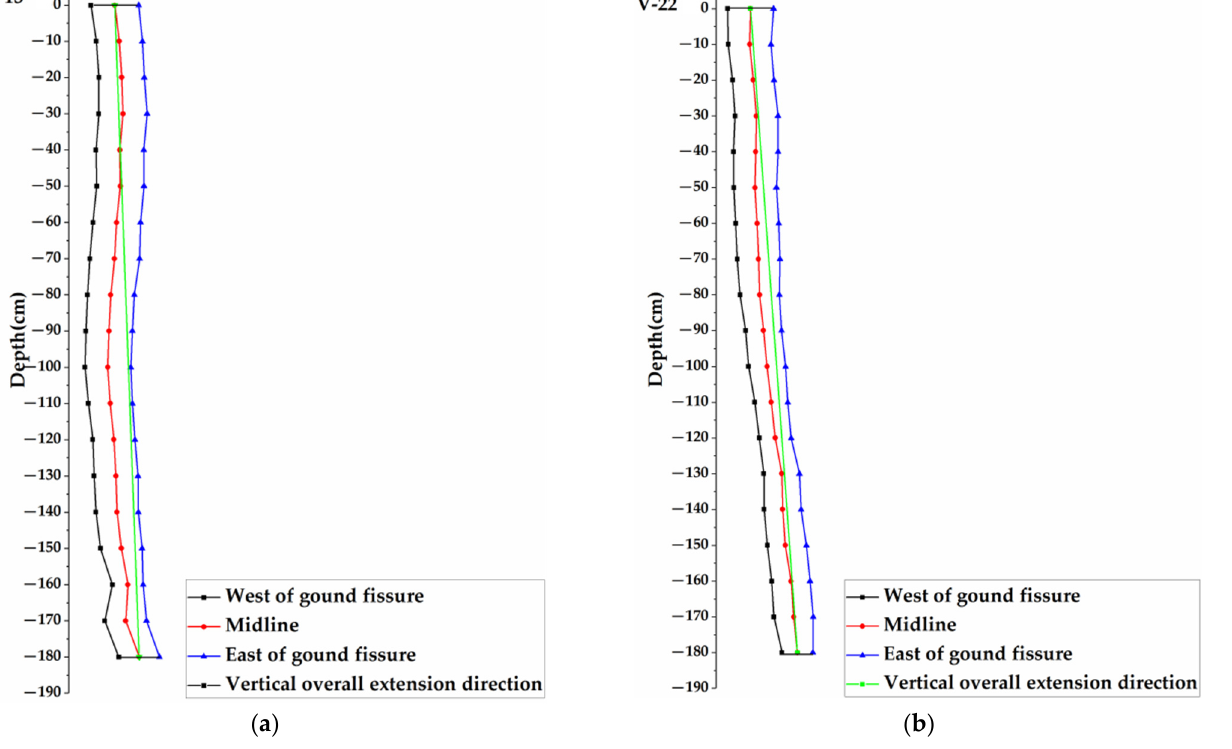
Figure 16. The vertical overall extension angle of the ground fissure: ( a ) The vertical overall extension angle of V-13; ( b ) The vertical overall extension angle of V-22.